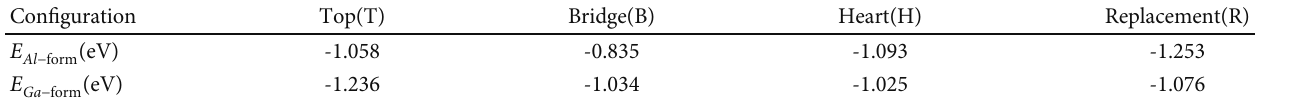
Table 1: Formation energy of Al- and Ga-doped Gra at T, B, H, and R sites.